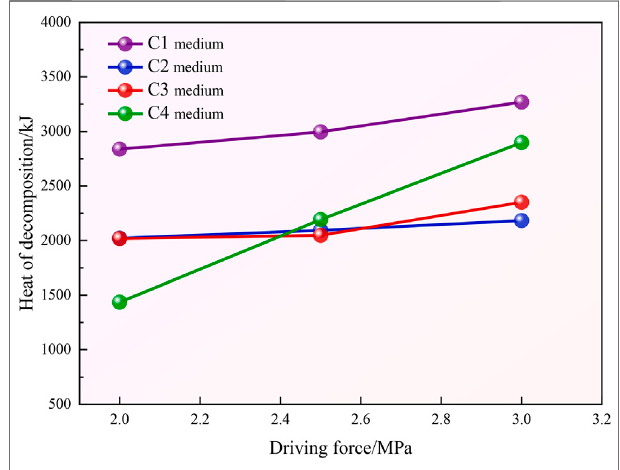
FIGURE9| ComparisonoftheheatofdecompositionofCO 2 hydratesin the C1-C4 systems.